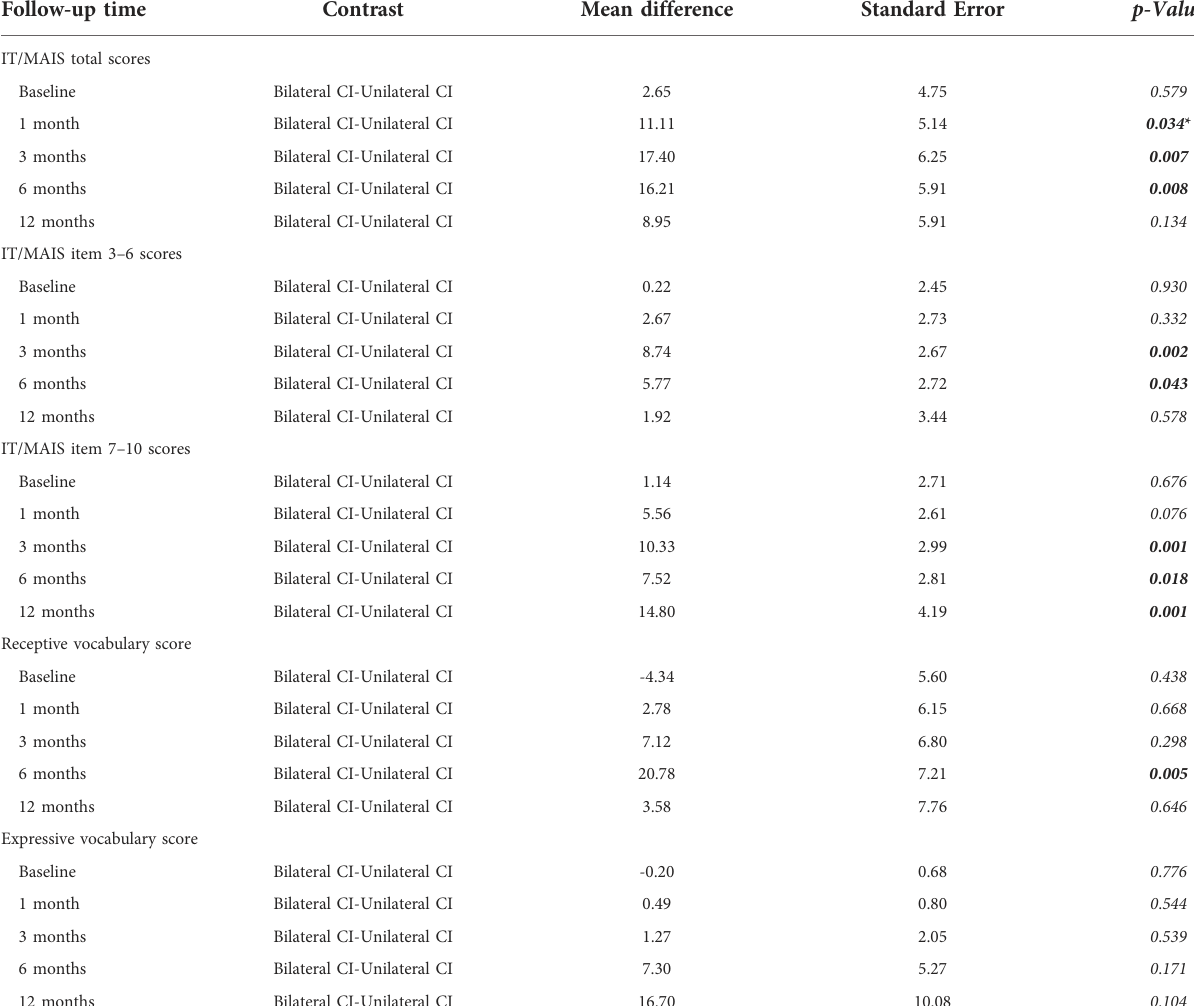
TABLE 3 Comparing BICI group to UCI group for each follow-up intervals. Follow-up